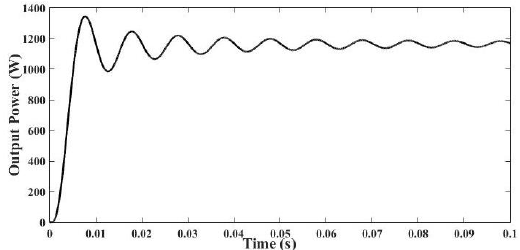
Figure 11. Simulation results of output average power ( P ).